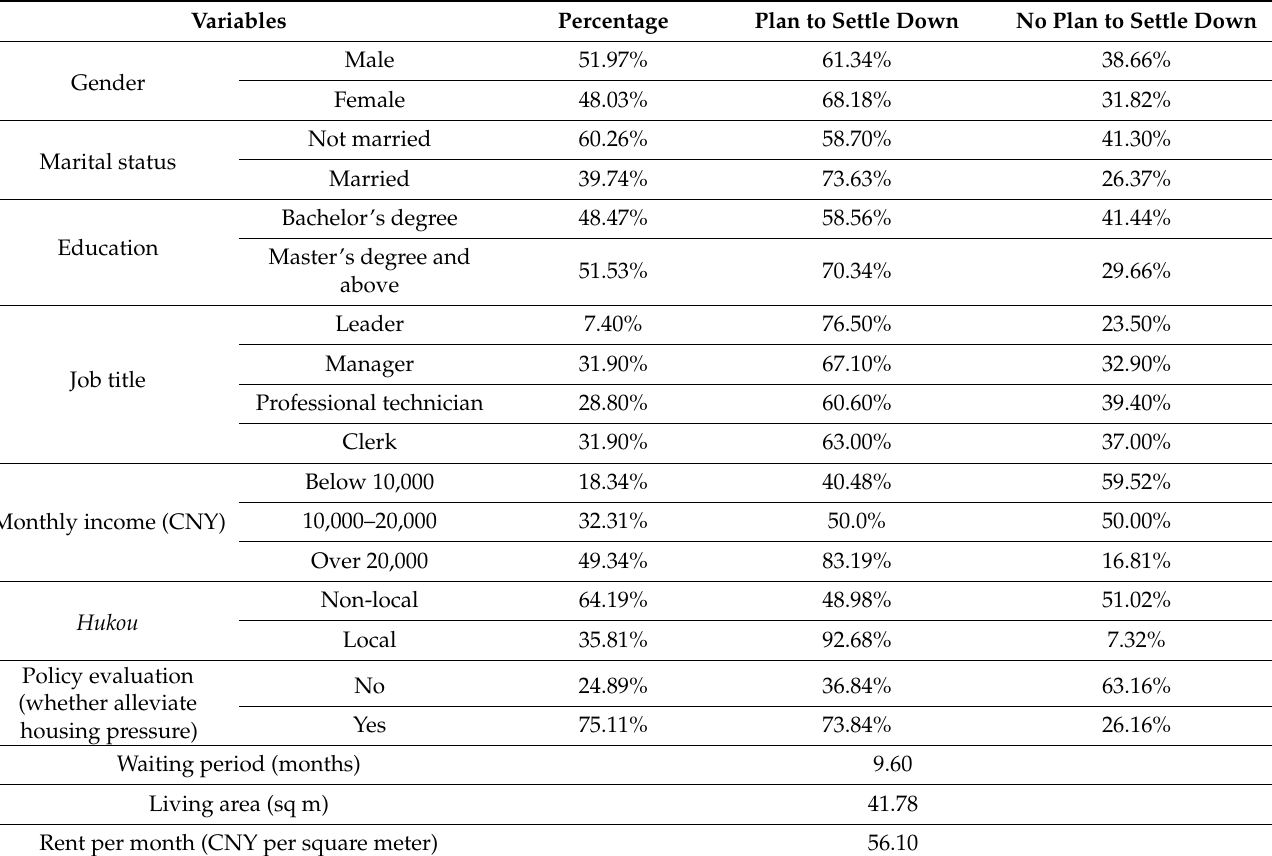
Table 3. Descriptive